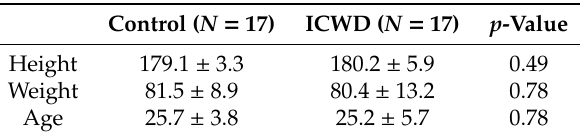
Table 1. Anthropometric characteristics of each group. Height in cm, weight in kg and age in years. Mean ± standard deviation. For each variable, the di ff erence between groups was assessed with a t-test. ICWD corresponds to income compensated wage